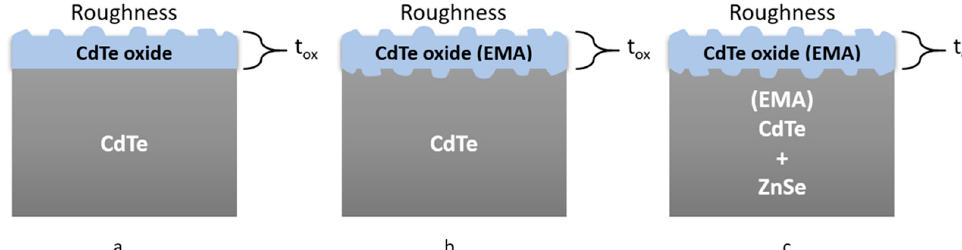
Figure 1. Model structures for fitting the ellipsometry experimental data. ( a ) Simple model with a flat interface between the substrate and oxide layer and with surface roughness, ( b ) EMA structure model with the CdTe substrate and CdTe oxide with surface roughness, ( c ) double EMA model with EMA as a substrate of CdTe and ZnTe and the substrate EMA and oxide CdTe with surface roughness. In all the models, the substrate is a semi-infinite layer, and the thickness of the oxide layer is denoted by t ox .